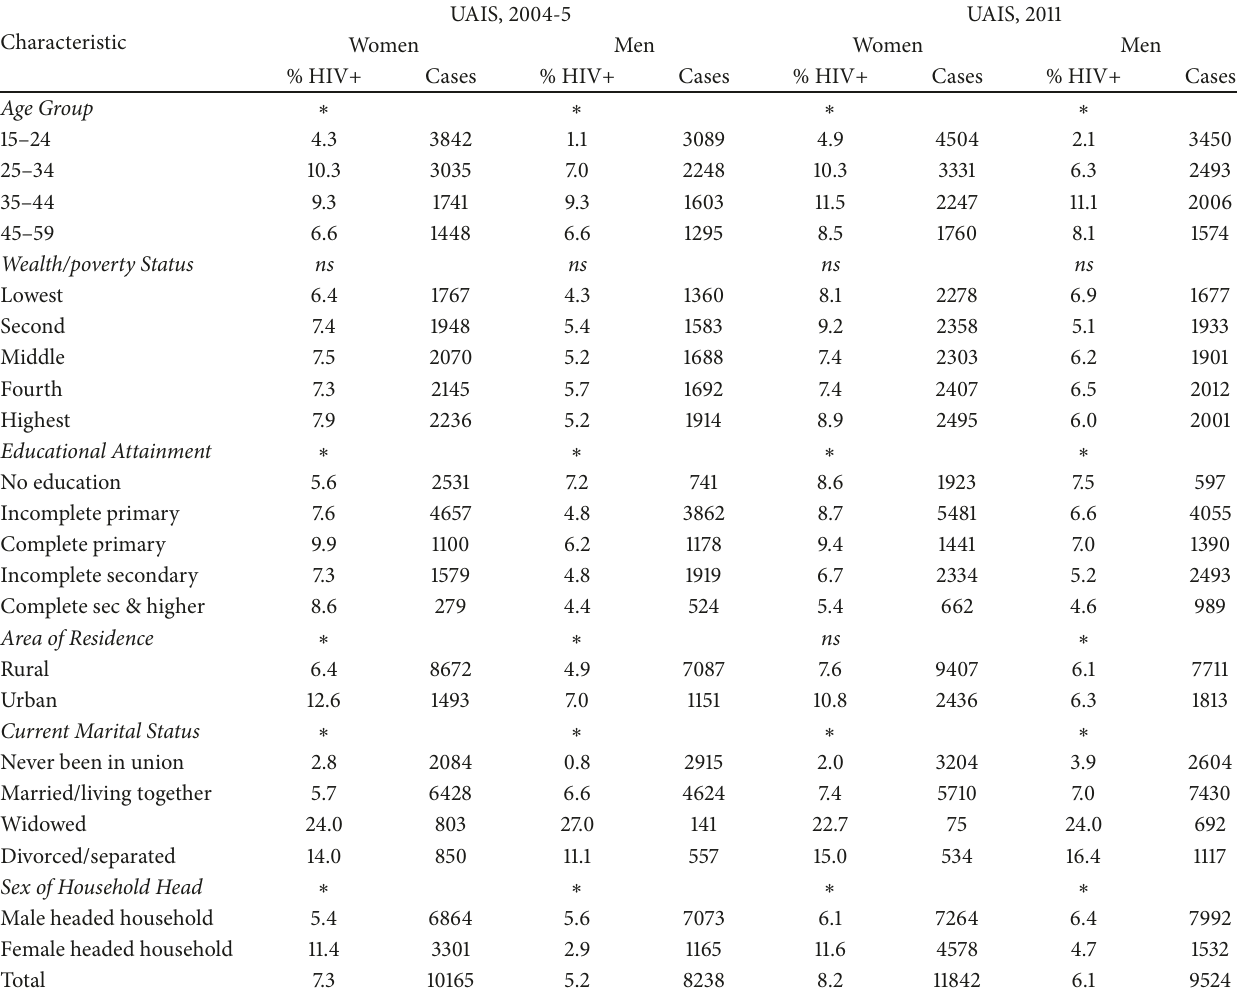
Table 1: Weighted HIV prevalence by key characteristics, Uganda AIDS Indicator Survey (UAIS), 2004-2005 and 2011.